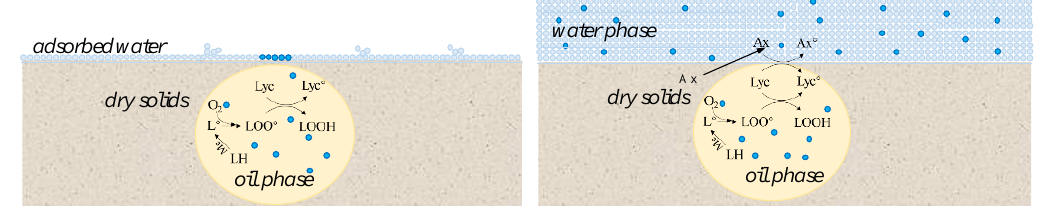
Figure 3. Model for oxidative reactions in dry tomato powder at a w below the monolayer moisture ( M o) (left side) and at a w well above M o (right side). = oxygen, = water; Lyc = lycopene, Ax = hydrophilic antioxidant, LH = unsaturated fatty acid, L° and LOO° = radicals, LOOH = peroxide. At a w below M o, MD could enhance oxygen binding due to decreased hydrophilicity of the matrix and larger pore sizes, thus increasing lycopene degradation rate. At a w well above M o, MD could encapsulate the hydrophilic antioxidants thus hampering lycopene regeneration. At the a w levels of 0.22 and 0.32 the rate for lycopene degradation decreased. These a w levels are